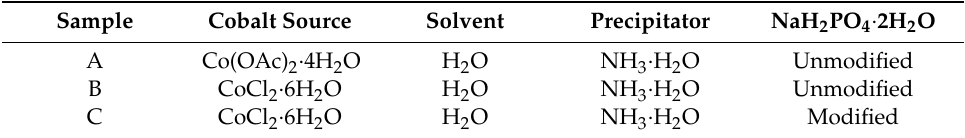
Figure 1. Schematic illustration of preparing Co 3 O 4 electrode materials by gas-phase di ff usion precipitation method. Table 1. Co 3 O 4 electrode materials were prepared by gas-phase di ff usion precipitation